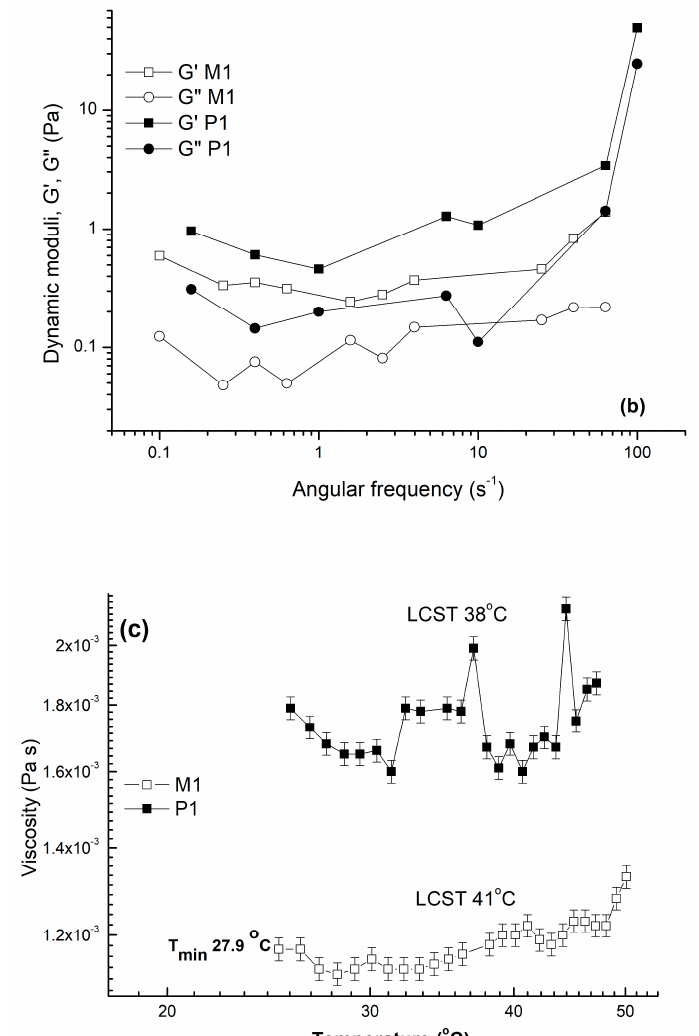
Figure 3. Rheological curves of CS-g-PNIPAAm/PVA 80/20 (M1) and CS-g-PNIPAAm/PVA 80/20- PGT (P1). ( a ) Viscosity dependency on the share rate and share stress–share rate curves; ( b ) Variation of dynamic moduli, storage G’, and loss G’’ moduli with the angular frequency; ( c ) Temperature sweep curves.